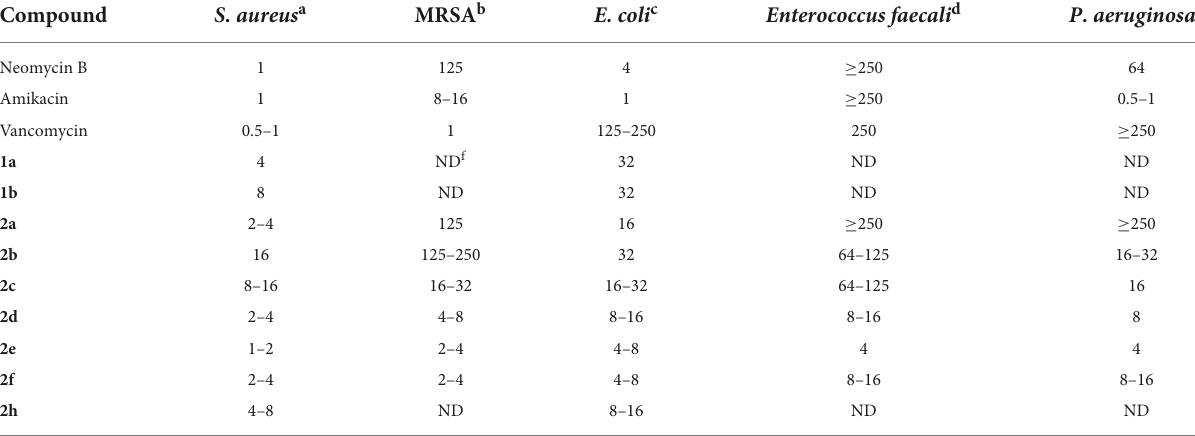
TABLE 2 MICs ( µ g/mL) of 5 (cid:48)(cid:48) -modified neomycin AAGs against MRSA and VRE (Zhang et al., 2008, 2009). Compound